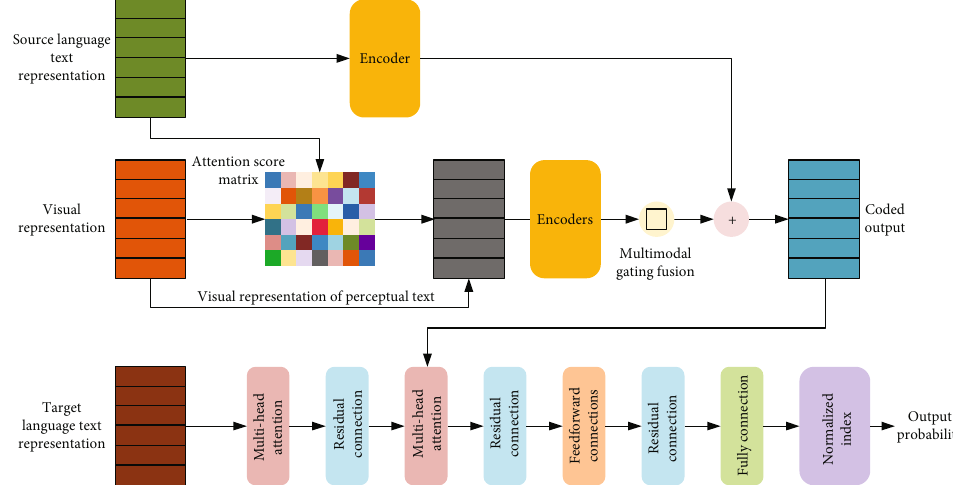
Figure 5: A framework for a generic multimodal machine translation model based on multimedia visual